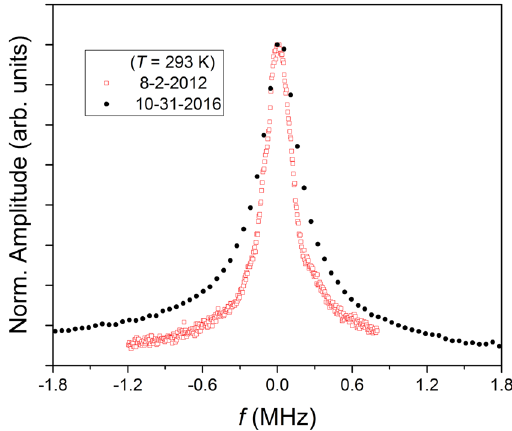
Figure 5. Time dependence of the fundamental mode. Normalized amplitude as a function of f - f O , where f O is the fundamental frequency, measured at room temperature and at two separate times: after initial exfoliation (8- 2-2012) and nearly 4 years and 3 months later